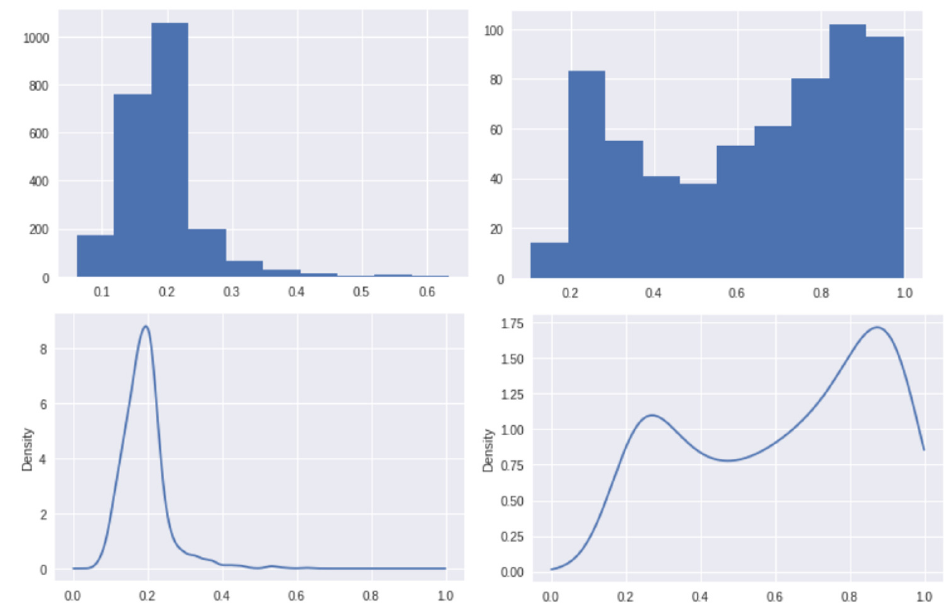
Figure 8. The histograms ( top row) and PDFs ( bottom row) for Non-Defect class ( left column) and Defect class ( right column) of GDXray dataset